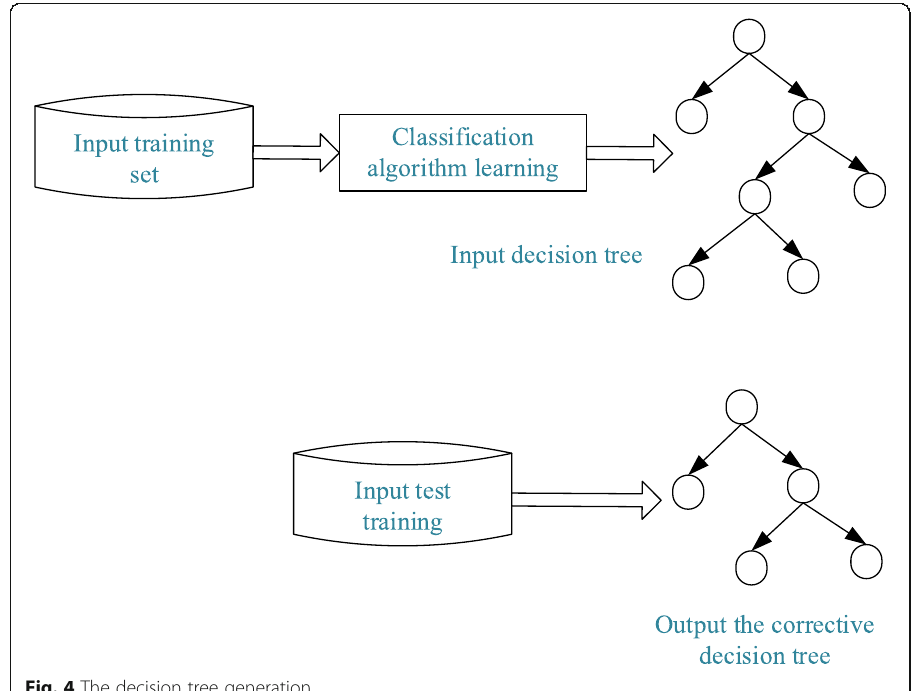
Fig. 4 The decision tree